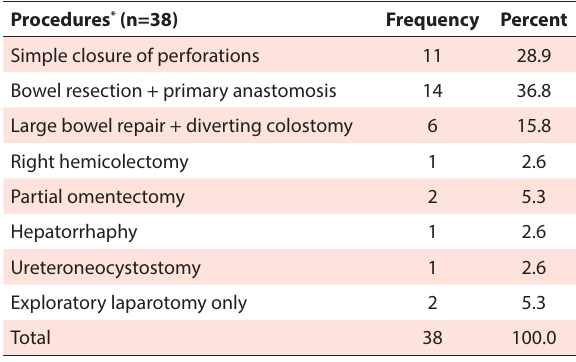
Table 3. Surgical procedures